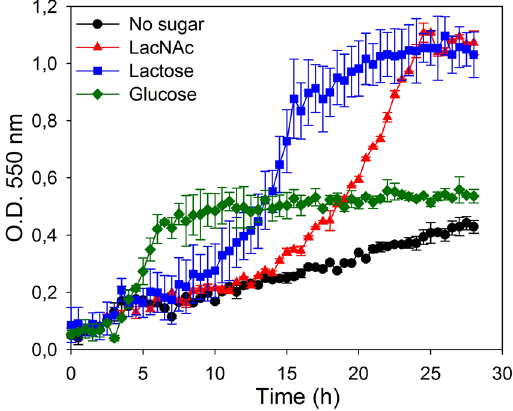
Figure 2. Growth curves of Lactobacillus casei wild type strain BL23 on sugar-free MRS without carbon source (black), with N -acetyllactosamine (LacNAc) (red), lactose (blue) or glucose (green). Data presented are mean values based on at least three replicates. Error bars indicate standard